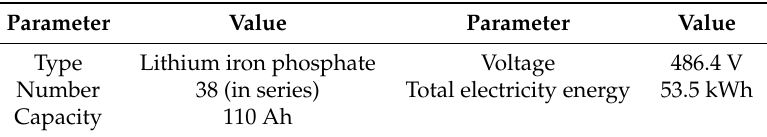
Table 4. Main parameters of the